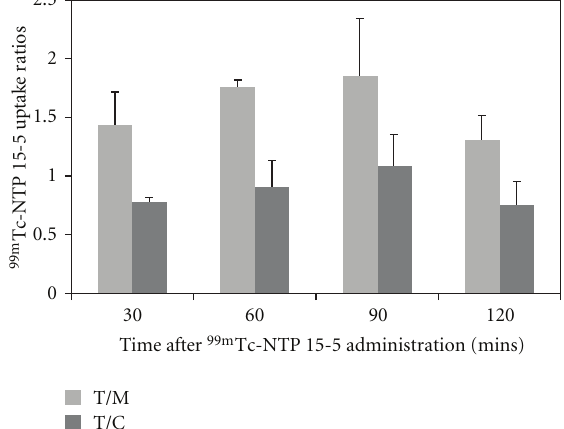
Figure 7: Disease incidence at each time point of study, according to 99m Tc-HMDP scintigraphy, 99m Tc-NTP 15-5 imaging, and calliper